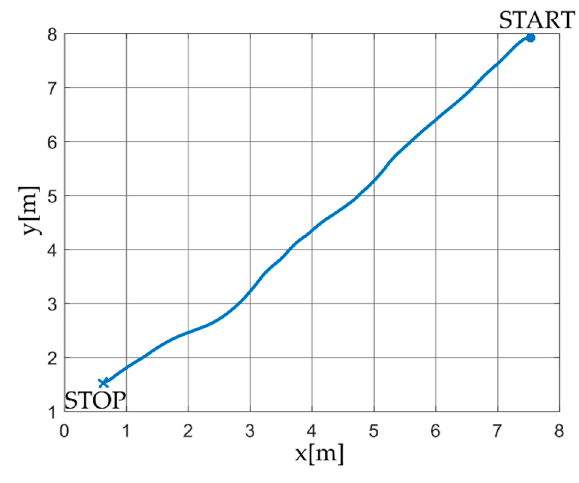
Figure 11. The path of the robot characteristic point related to the retroreflector.